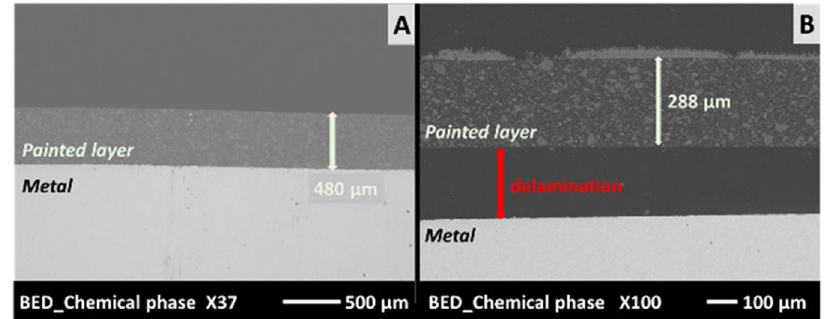
Fig. 5 Scanning Electron Microscope (SEM) pictures of different samples cross-sections at different stages of paint degradation. In ( A ), the case of freshly painted DH36 steel without defects and, in ( B ), a painted DH36 steel aged after 597 days of immersion. Both are immersed in arti fi cial seawater at 20 °C naturally aerated in static condition. These images are obtained by Energy Dispersive X-ray Spectroscopy (EDS) using a Backscattered Electron Detector (BED). Table 1. Estimated impedance parameters for the different components of the EEC representing the painted DH36 steel/arti fi cial seawater interface during the fi rst 48 days of immersion at 20 °C, in naturally aerated solution and static conditions with the estimated frequency range concerned by the CPE paint phenomenon.